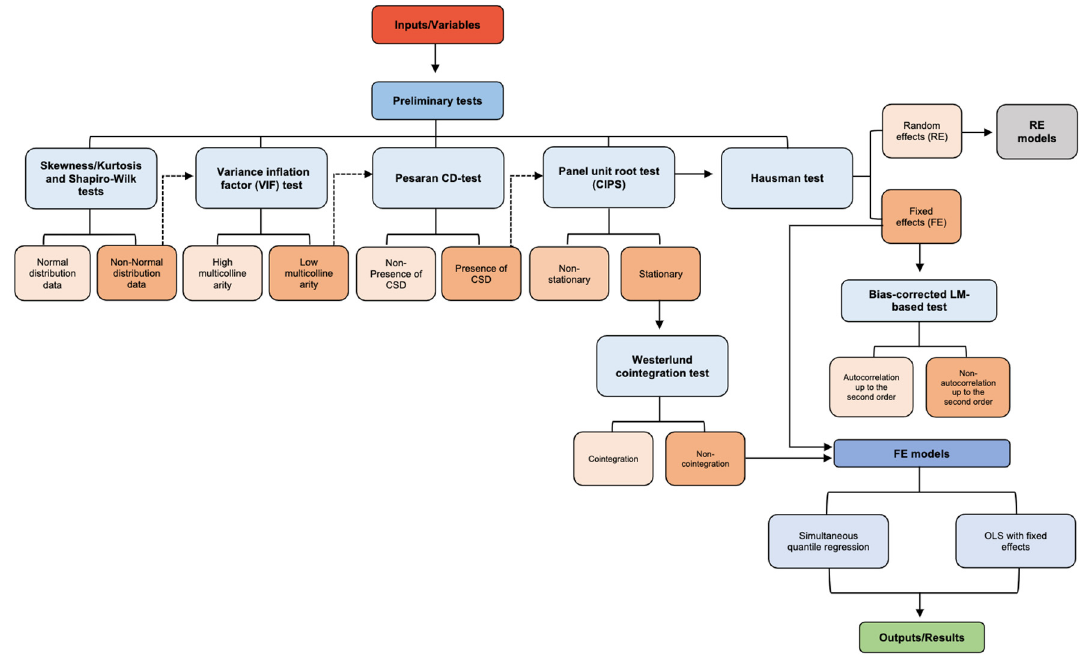
Figure 5. Methodology strategy. The authors created this figure.